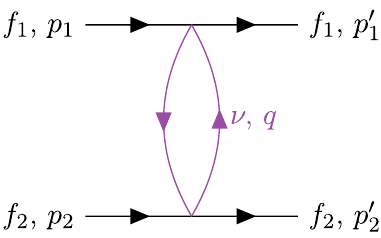
Figure 1. Feynman diagram contributing to the relevant scattering amplitude in vacuum.